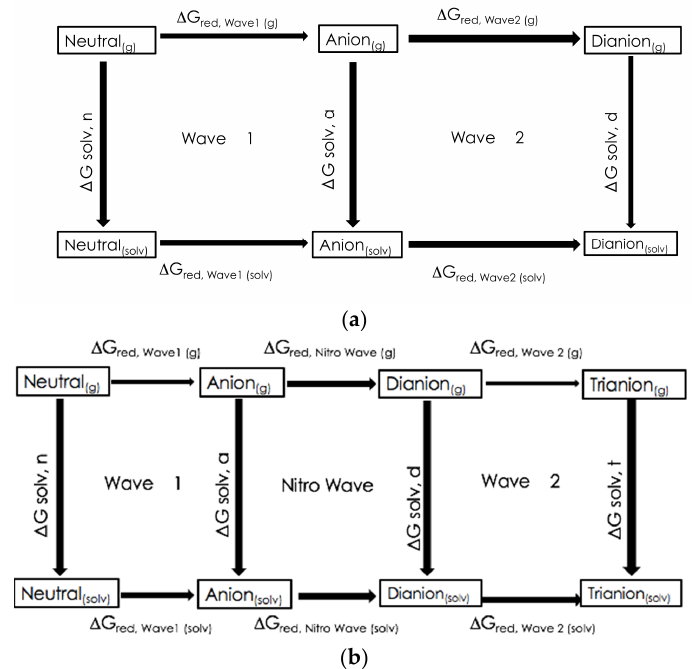
Figure 3. A visual representation of the thermodynamic cycles used to calculate G red : ( a ) Wave 1 (1st N-oxide reduction) and Wave 2 (2nd N-oxide reduction) for derivatives A1–D4 and ( b ) Wave 1 (1st N-oxide reduction), Nitro Wave (nitro group reduction) and Wave 2 (2nd N-oxide reduction) for derivatives E1–E4.